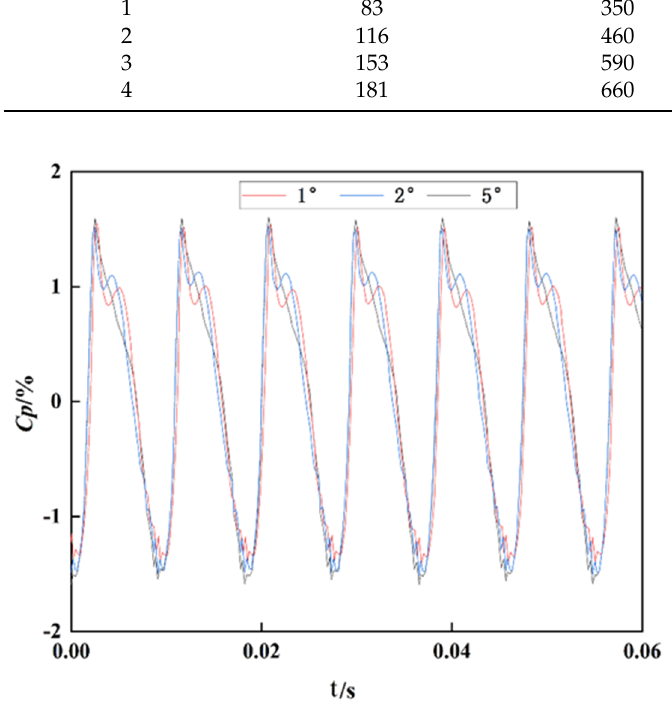
Figure 2. Time step independence verification. Table 1. Basic geometric parameters of Francis turbine.